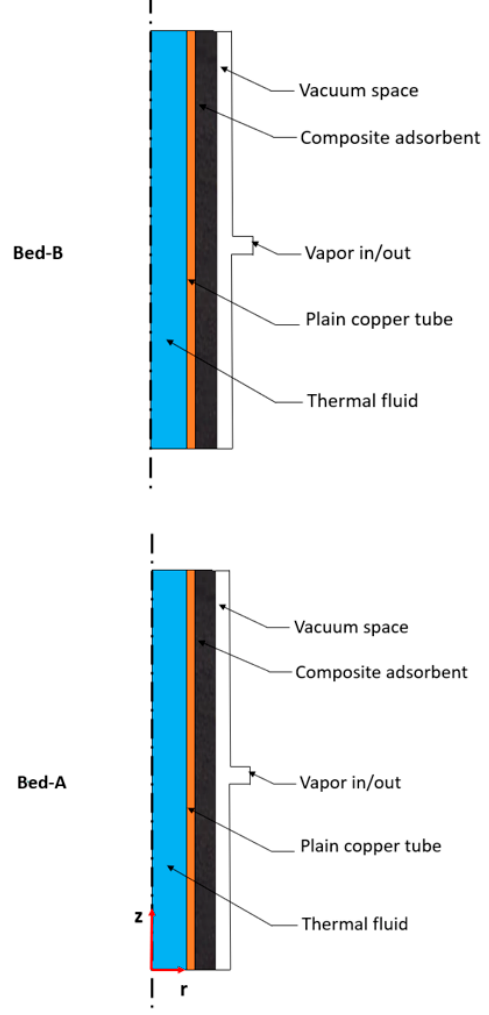
Figure 2. The two-dimensional axisymmetric domains applied in the mathematical modelling. The ethanol vapor behaves as an ideal